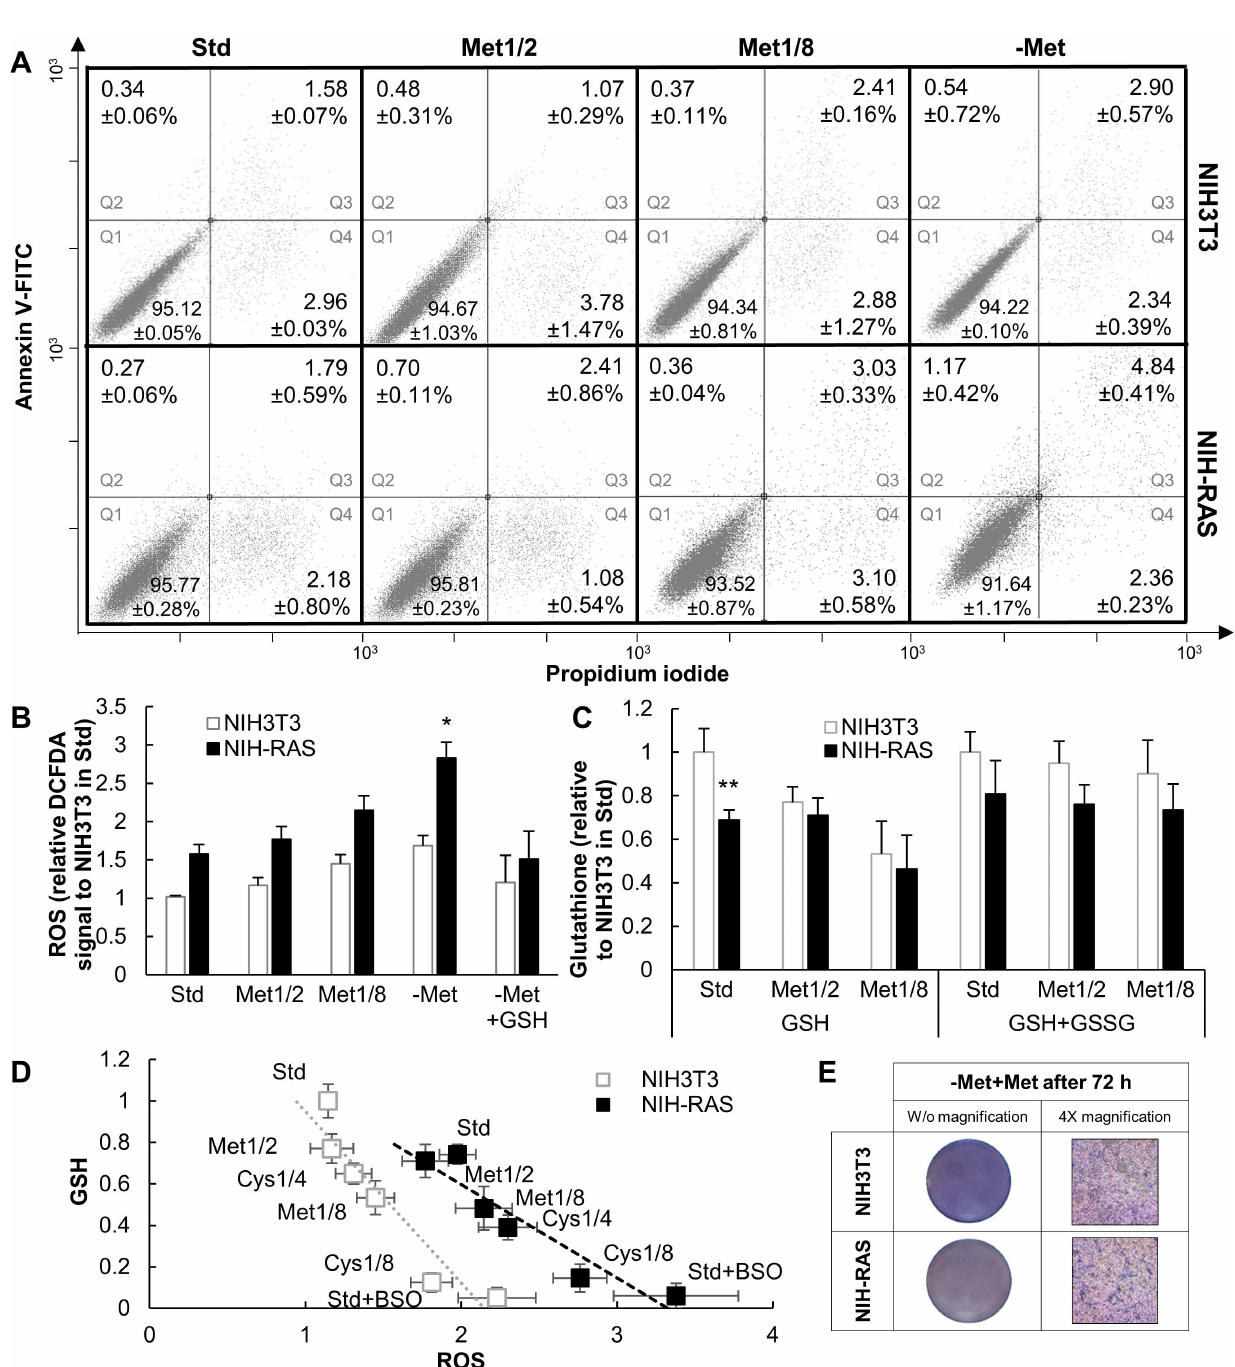
Fig 3. Viability and redox state under methionine deprivation and limitation. (A) Representative dot plots for NIH3T3 and NIH-RAS cells stained with Annexin V-FITC and propidiumiodide and analyzedby FACS after 30 h of growth under conditions indicated. Q1 = quadrant 1, healthy cell; Q2 = quadrant 2, early apoptotic cells; Q3 = quadrant3, late apoptotic cells; Q4 = quadrant 4, necrotic cells. The values reported for each quadrant are the mean +/- standard deviationof three independent experiments. (B) Relative ROS levels in NIH3T3 and NIH-RAS cells grown for 48 h under conditionsindicatedas determined by DCFDA (2’,7’-dichlorodihydrofluorescein diacetate)staining. Each bar represents the mean of at least three independent experiments with error bars representingthe standard deviation. (C) Reducedand total glutathionelevels (measured as describedin [55]) in NIH3T3 and NIH-RAS cells grown for 48 h under conditionsindicated. Each bar represents the mean of at least three independent experiments with error bars representingthe standard deviation * P < 0.05; ** P < 0.01 (Student’s t -test). (D) Negative correlationbetween reducedglutathionelevels and ROS levels in NIH3T3 and NIH-RAS cells grown under conditionsindicated. Linear regressioncurves are not parallelwith a 99.9% confidence interval; Student’s t -test. (E) Crystal violet staining of